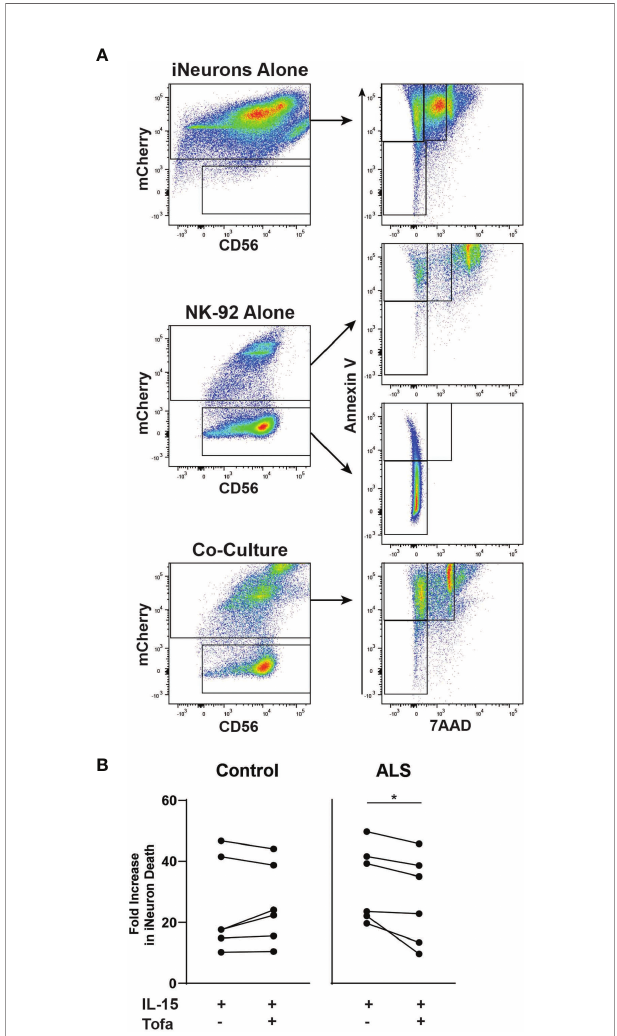
FIGURE 2 | Tofacitinib decreases the cytotoxicity of NK-92 to motor neurons in an in vitro ALS model. iNeurons were differentiated from control- or ALS- participant derived iPSCs and were co-cultured for four hours with pretreated NK-92 cells (IL-15 ± tofacitinib); cell death was quantitated by fl ow cytometry. (A) Gating strategy for quantitating cell death of iNeurons cultured alone, of NK- 92 cells cultured alone, and iNeuron and NK-92 cell co-culture. Dead iNeurons were characterized by positive fl uorescence levels of annexin V (apoptosis) and moderate levels of 7AAD viability dye (cell death). (B) The rate of iNeuron death was quantitated in control- and ALS-derived iNeurons following co-culture with NK-92 cells; data were normalized to cell death rates from co-culture with Unstimulated NK-92 cells; n = 6 independent experiments. Comparisons were by paired t-test to assessed paired, non-normally distributed data. * P <